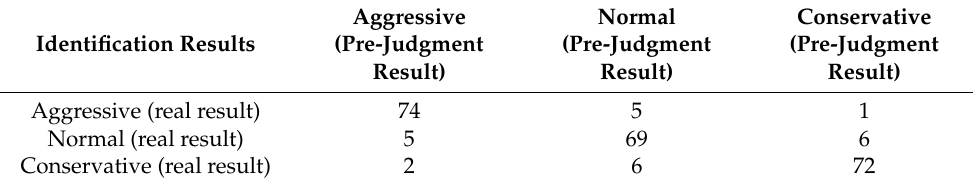
Table 18. BPNN driving propensity identification results.